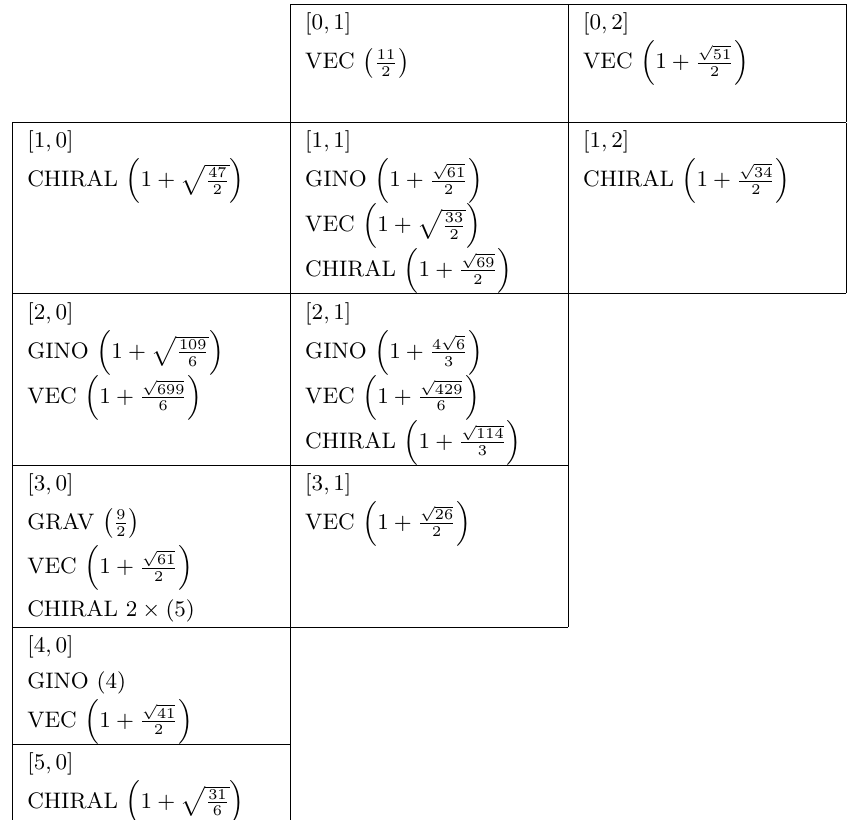
Table 10 . Supermultiplets at KK level n = 3 for the N = 1 G 2 -invariant AdS 4 solution of type IIA.